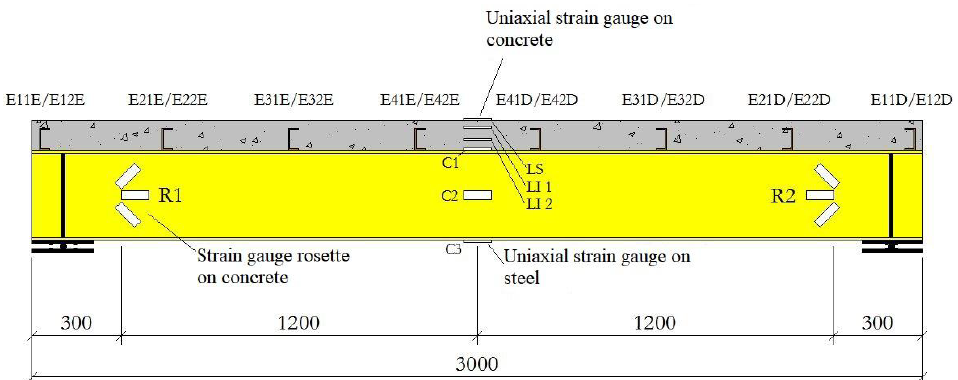
Figure 11. Side view of the positioning of the strain gauges on the beam.